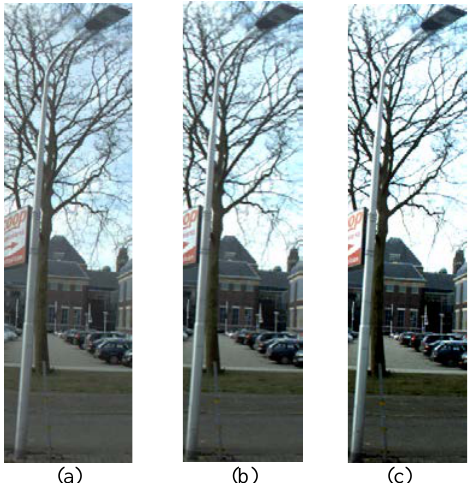
3.2.2 Data Augmentation Image augmentation is applied on the cropped image with contrast enhancing degree from 1.3 to 1.8 as shown in Figure 6.